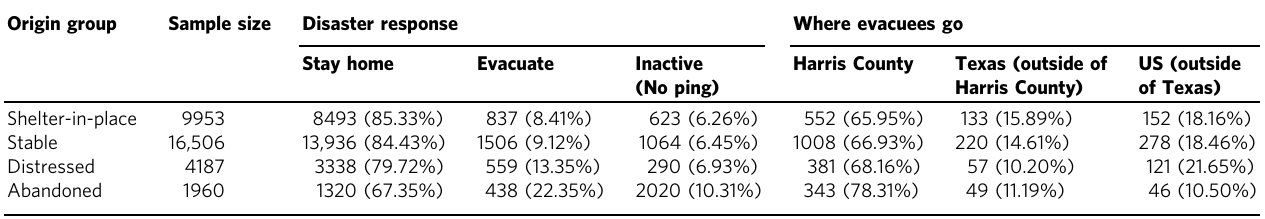
Table 3 Disparities in disaster response and evacuation patterns across the four cluster